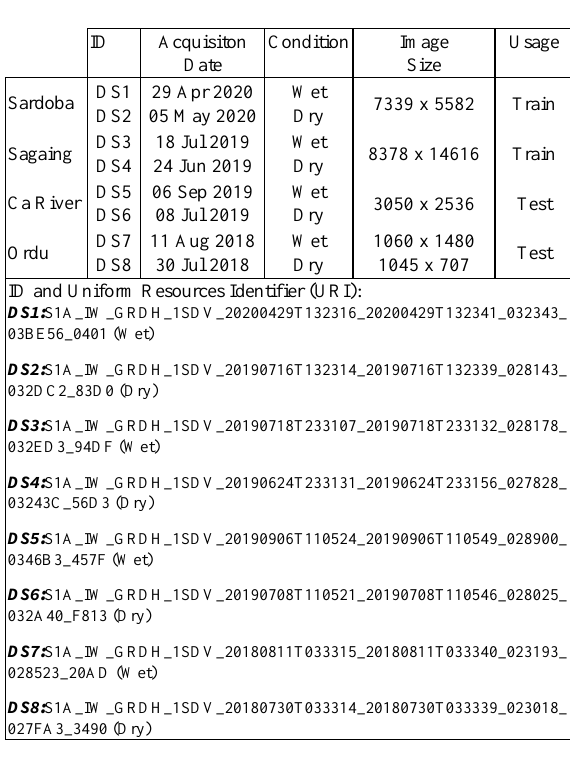
Table 1 . Basic specifications of the Sentinel-1 datasets used in the